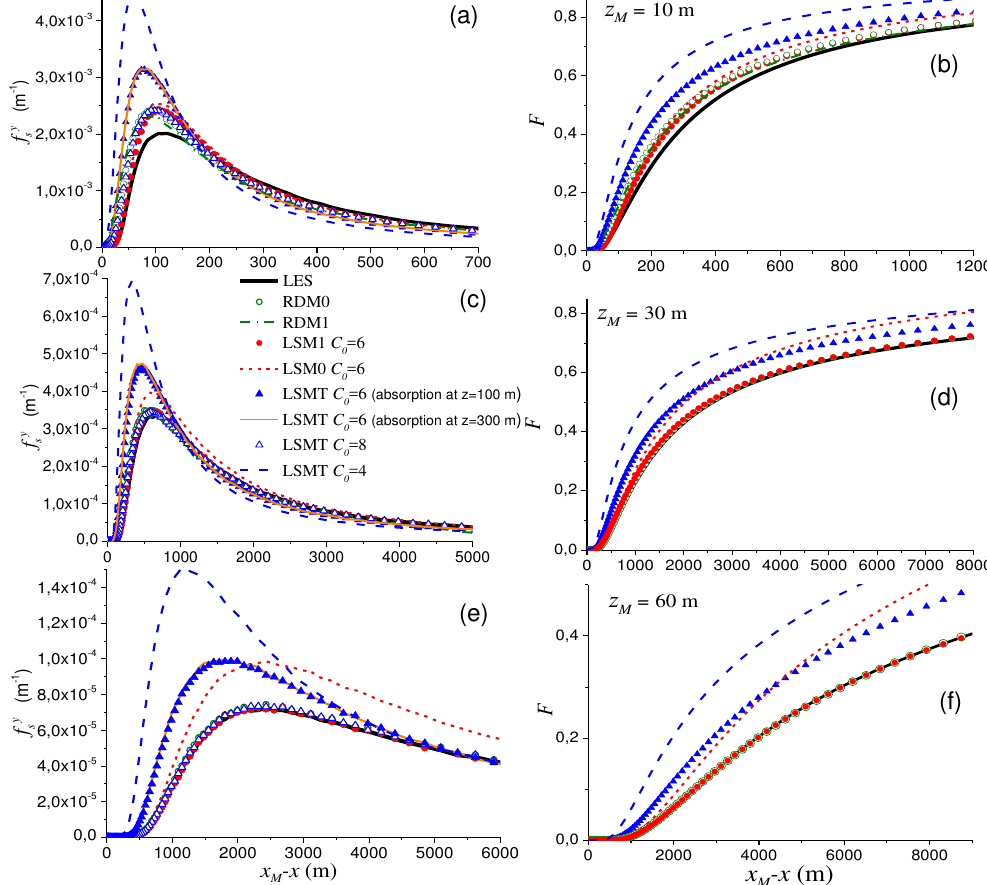
Figure 11. Crosswind-integrated footprints f y s (a, c, e) and cumulative footprints F (b, d, f) for sensor heights z M = 10m (a, b) , z M = 30m (c, d) and z M = 60m (e, f) . Solid lines – LES with grid steps (cid:49) g = 2.0m. Blue triangles – LSMT (Thomson, 1987) with C 0 = 6 (absorption at z = 100m); open triangles – LSMT with C 0 = 8; blue dashed lines – LSMT with C 0 = 4. Orange curves – LSMT with C 0 = 6 (absorption at z = 300m). Short-dashed line – LSM0 (Lagranian stochastic model without a well-mixed condition). Red circles – LSM1 (an LSM with a WMC for vertical mixing). Open green circles – RDM0 (uncorrelated random displacement model). Dash-dot green line – RDM1 (random displacement model with correlation between the displacement